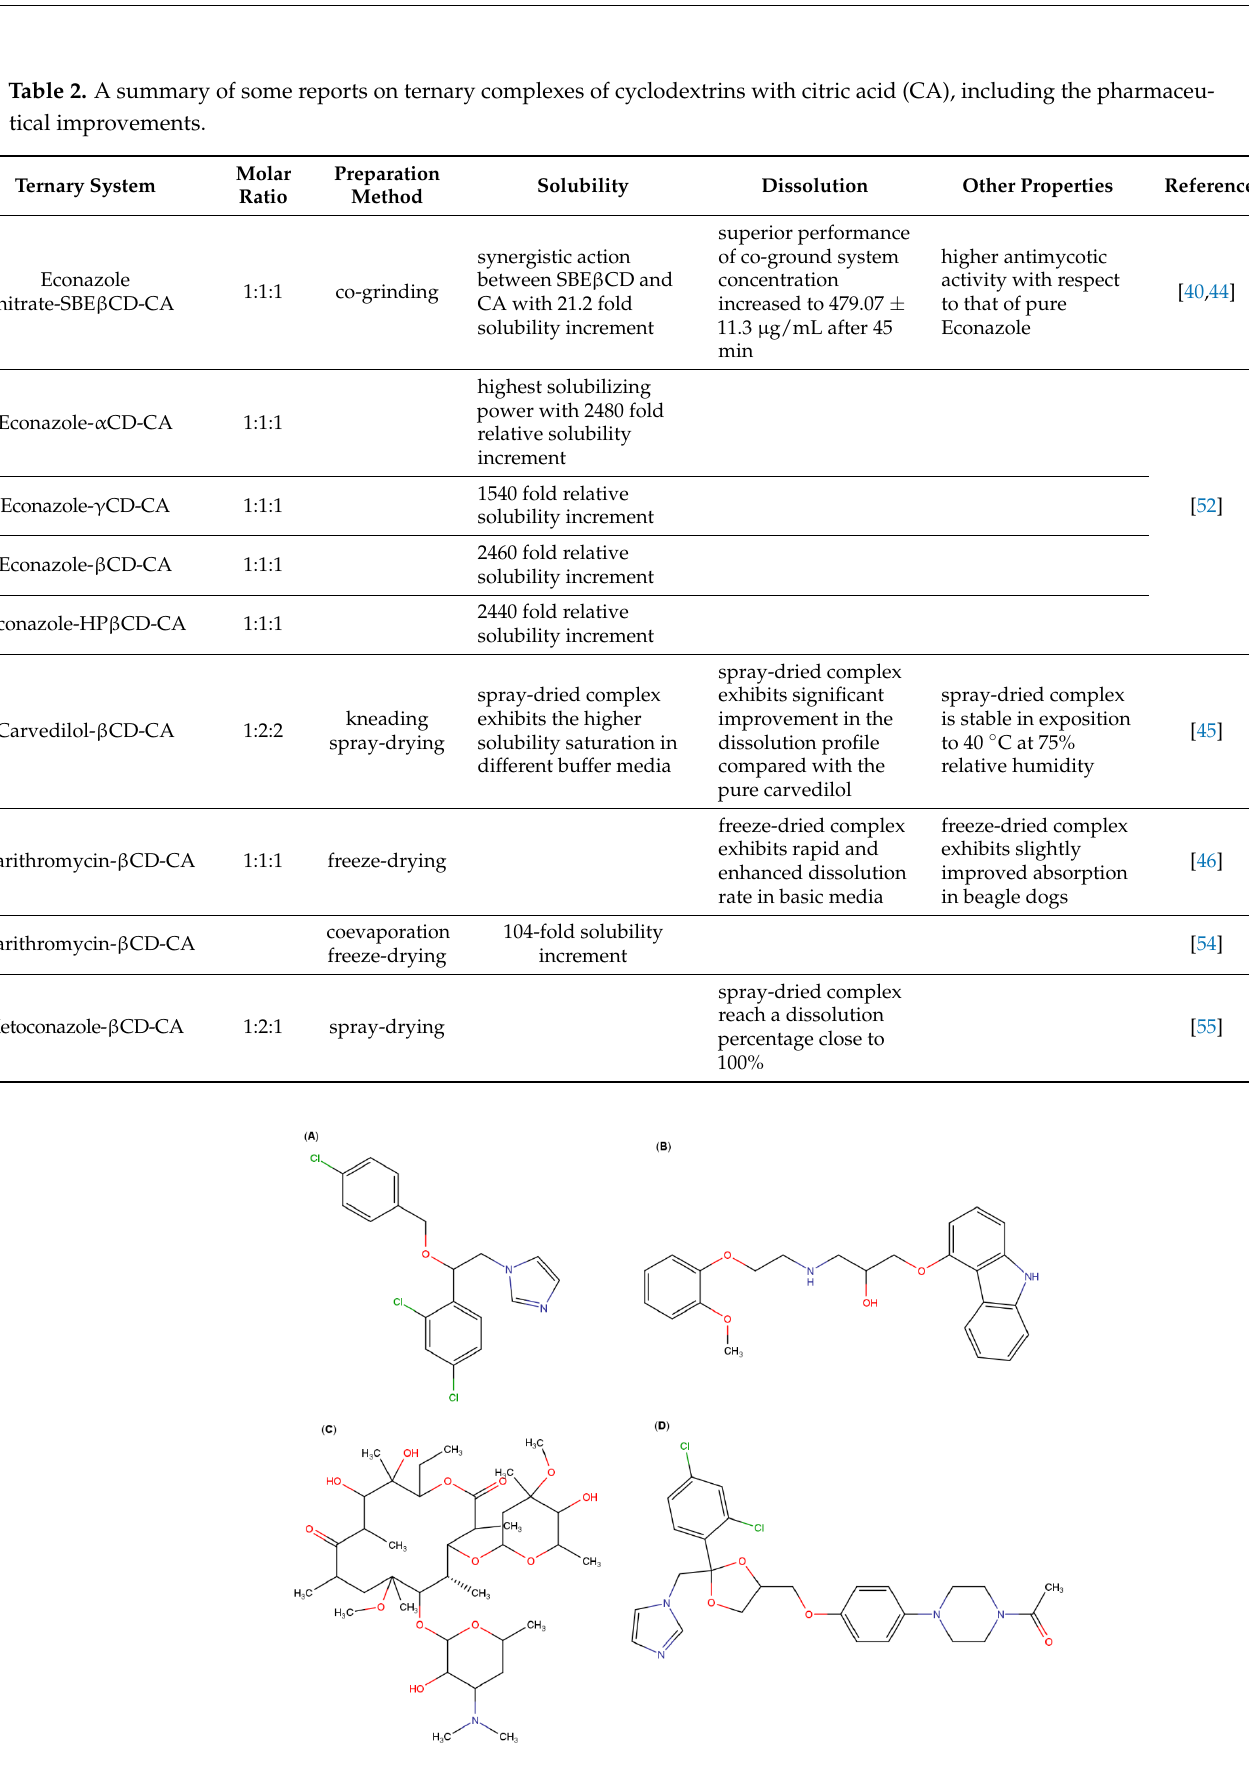
Table 2. A summary of some reports on ternary complexes of cyclodextrins with citric acid (CA), including the pharmaceu- tical improvements.